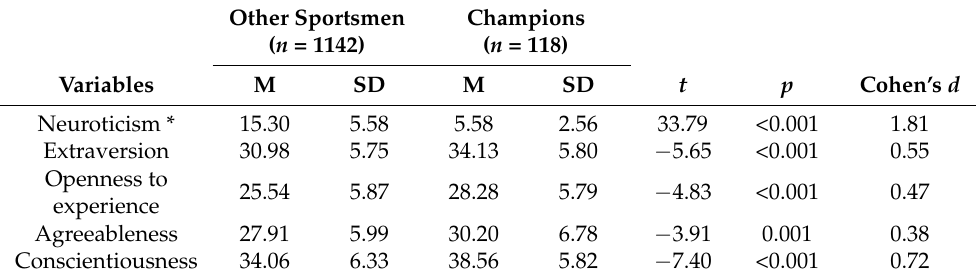
Table 1. Analysis of differences between champions and other athletes in the intensity of personality traits.